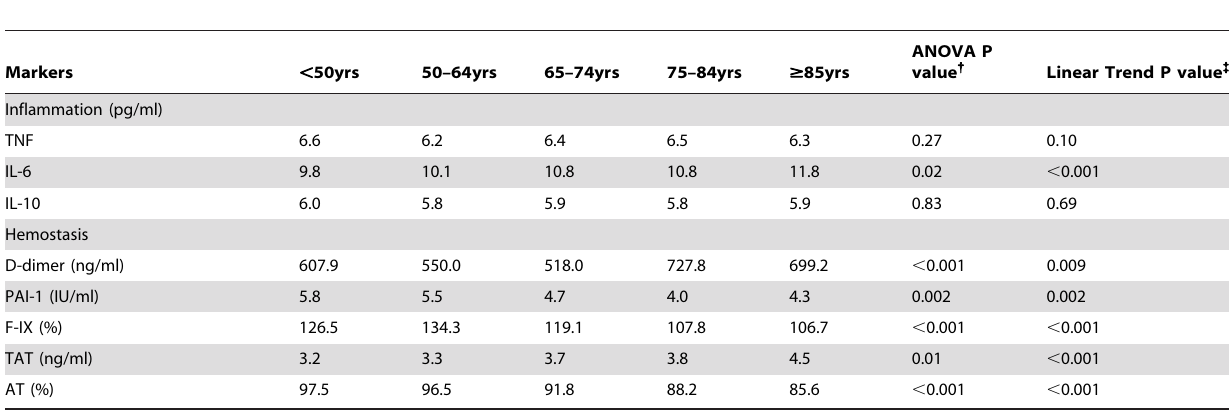
Table 6. Mean values of inflammation and hemostasis markers prior to discharge from hospital show a modest age-related increase in inflammation and coagulant